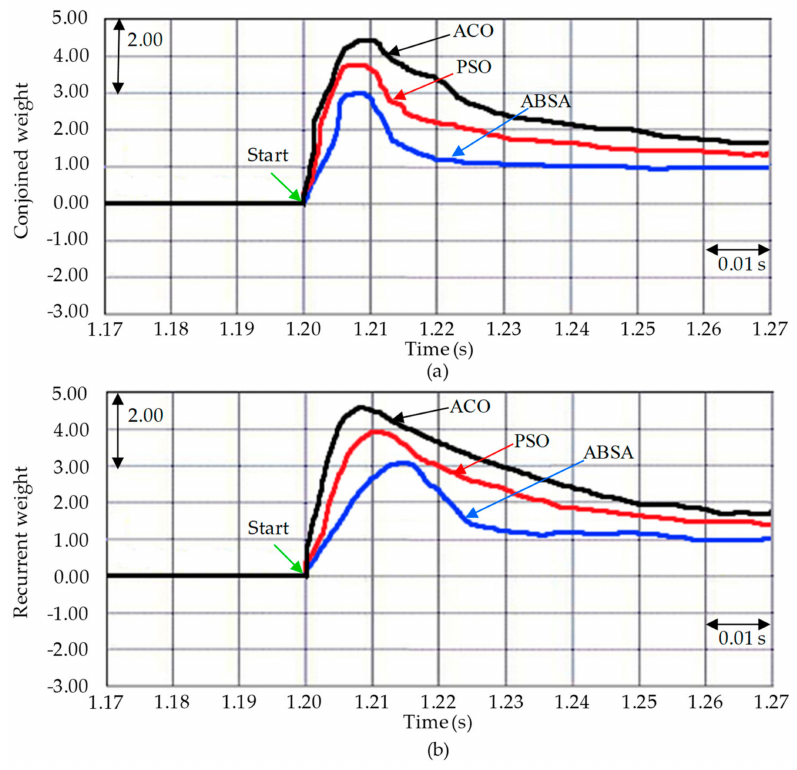
Figure 16. Responses of two weights via experimental results of test JB by adopting the ACO, PSO and ABSA methods for: ( a ) conjoined weight; ( b ) recurrent